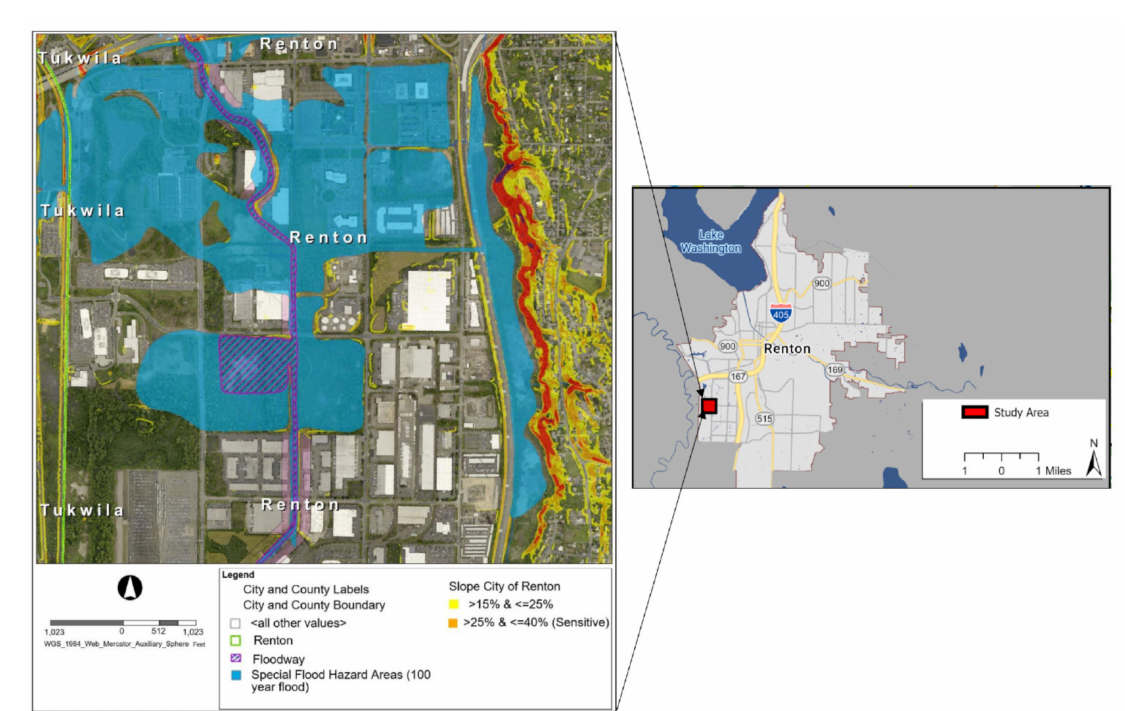
Figure 3. FEMA floodplain zones in part of the study area modified after CORMAP